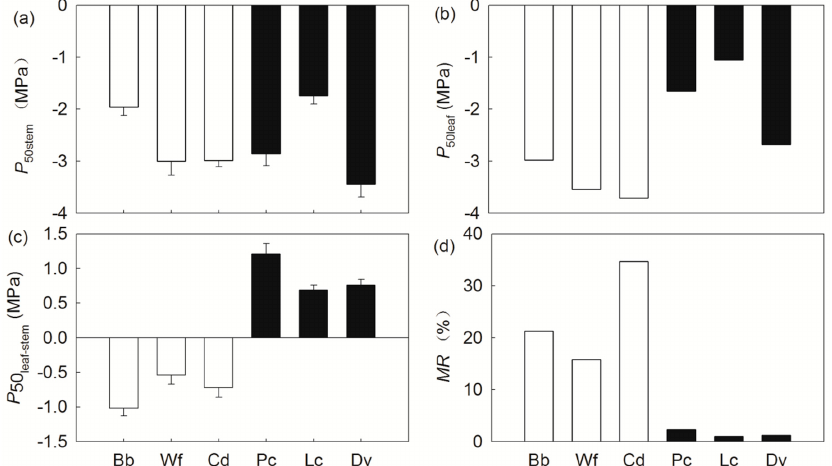
Figure 1. Hydraulic traits and mortality rate in six tree species. The abbreviation of functional traits is in Table 1. ( a ) P 50stem ; ( b ) P 50leaf ; ( c ) P 50leaf-stem ; ( d ) MR. The hollow and solid bars indicated the NS species and VS species, respectively. The codes of species: Bauhinia brachycarpa (Bb), Woodfordia fruticosa (Wf), Campylotropis delavayi (Cd), Polyalthia cerasoides (Pc), Lannea coromandelica (Lc), Diospyrosyunnanensis Table 2. Comparison of the mortality rate, recruitment rate, hydraulic, and photosynthetic traits between NS species and VS species. The abbreviations of the functional traits are shown in Table 1.